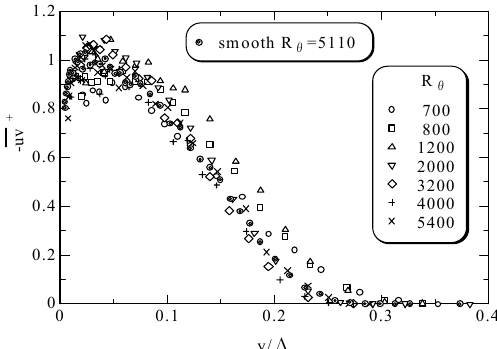
Fig.11 Similarity of the Reynolds shear stress profile normalized with the similarity